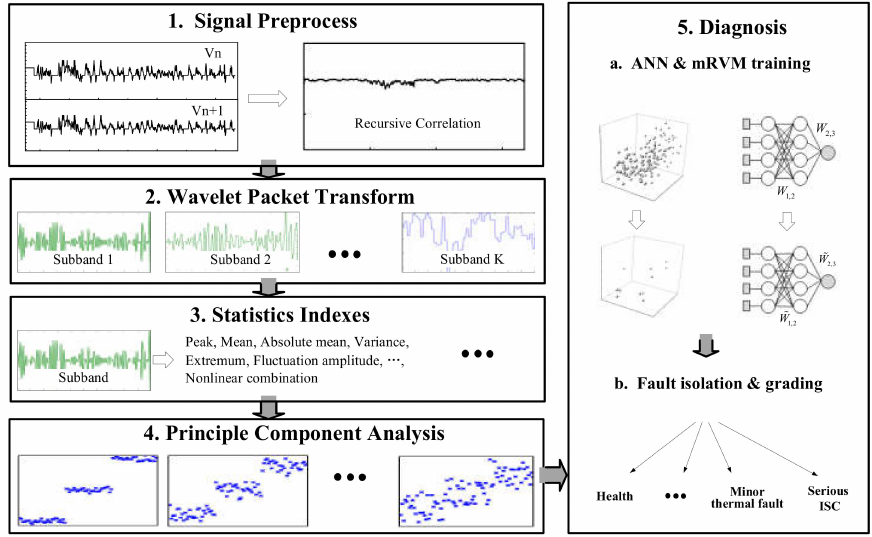
Figure 2. Schematic diagram of the proposed diagnosis